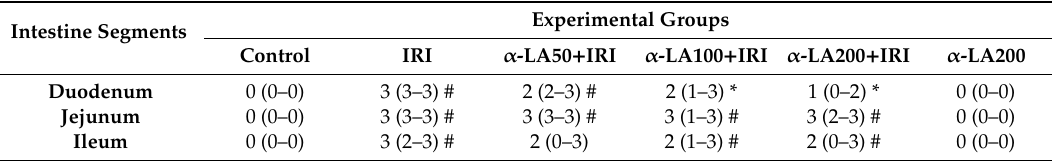
Table 1. Histological scores for intestinal